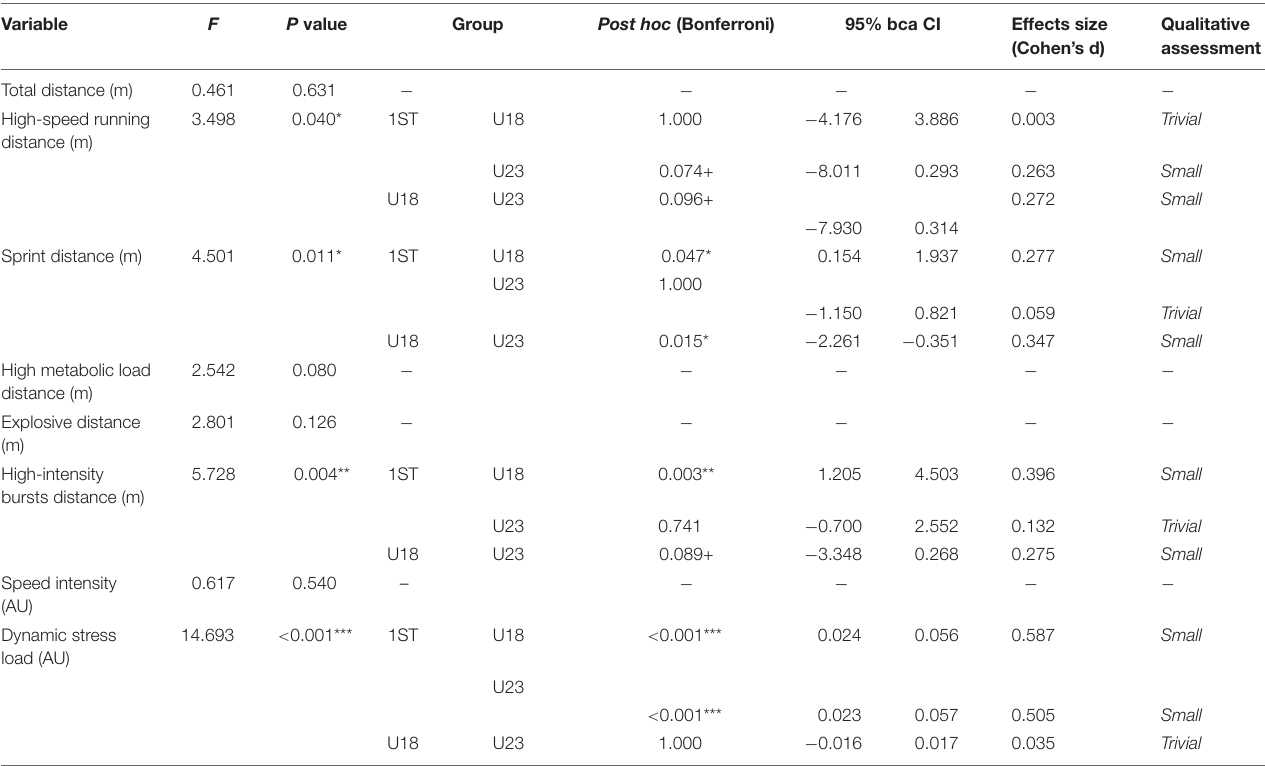
TABLE 2 | U18, U23, and 1ST team match day training load univariate comparisons.